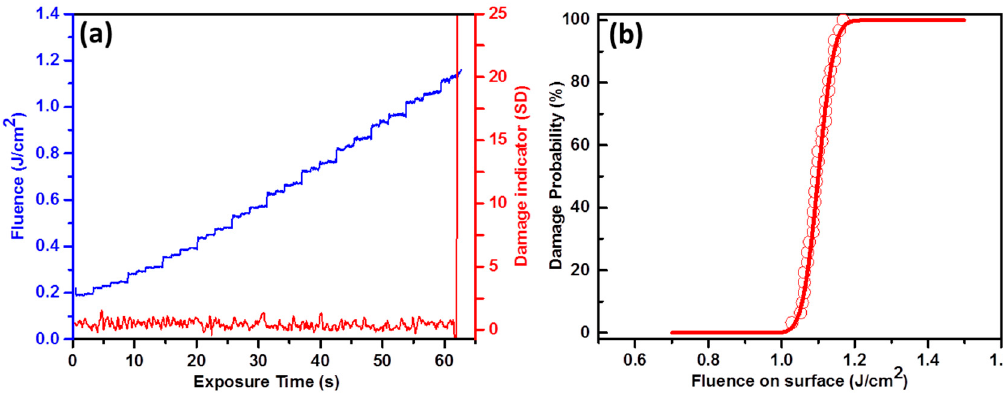
Figure 6. The sample evolution of the R-on-1 test (fluence vs. time) is shown in ( a ) for a tested MLD coating. ( b ) Shows the damage probability over several sites vs. R-on-1 damage threshold fluence on the sample surface at 45 deg AOI.